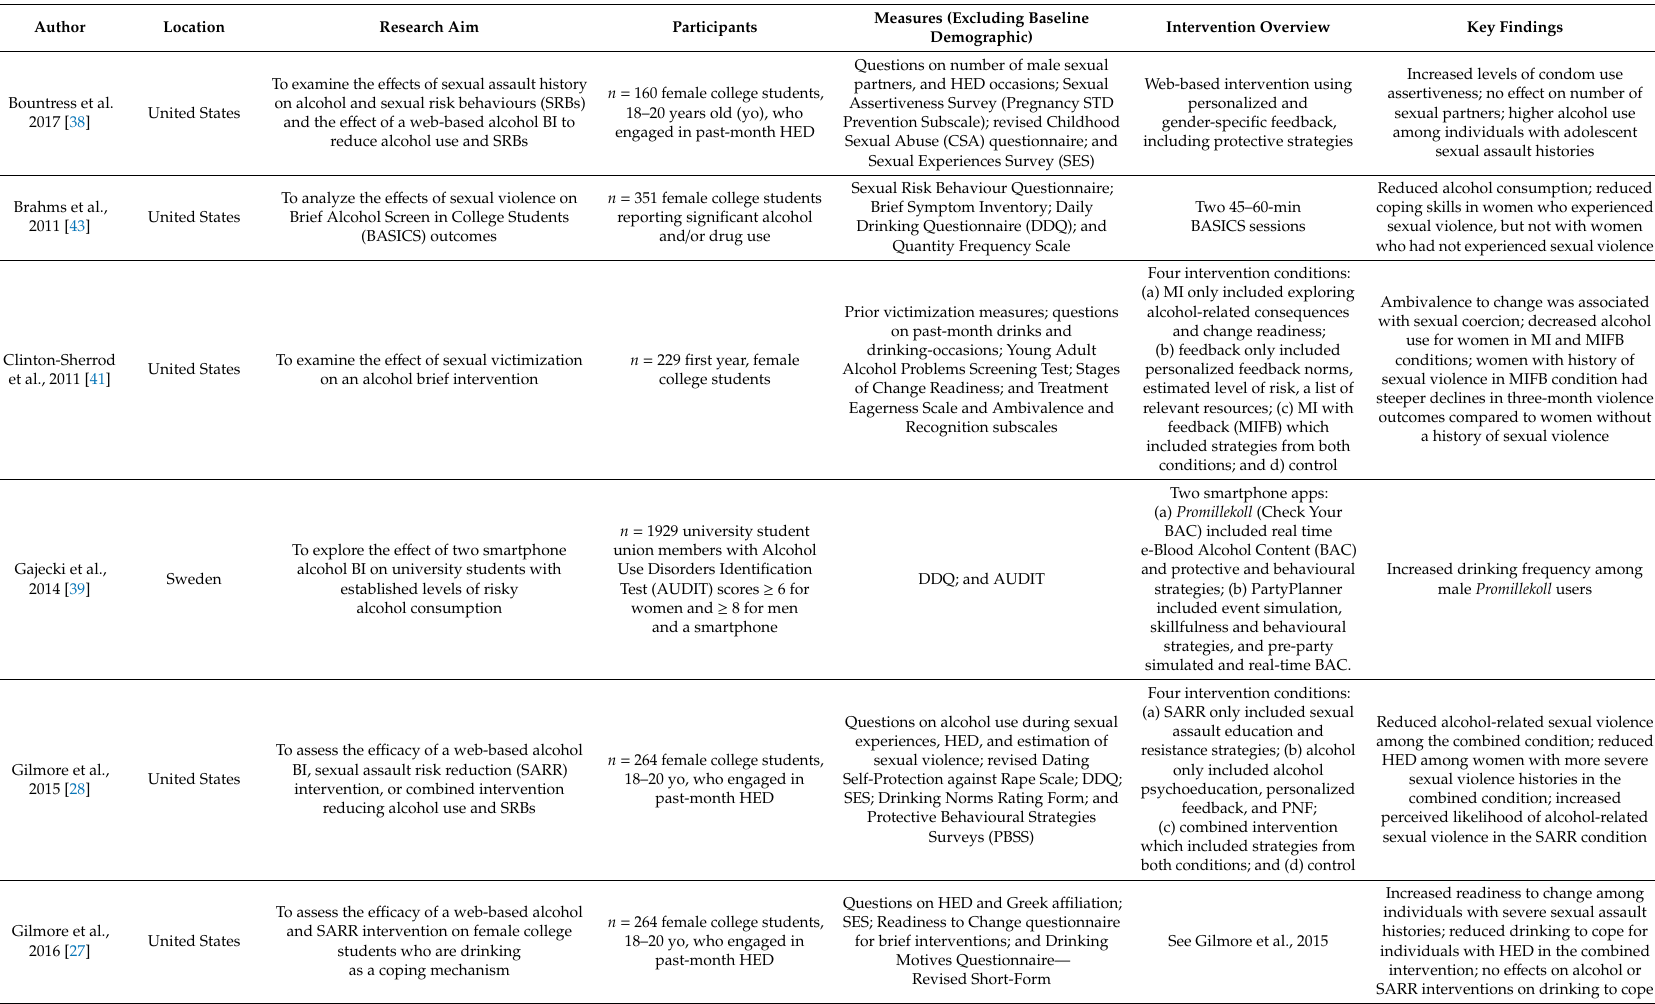
Table 1. Description of included